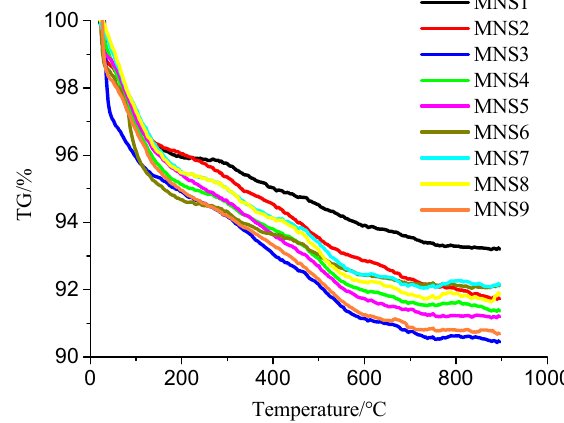
Figure 2. TG results of nine groups of MNS.